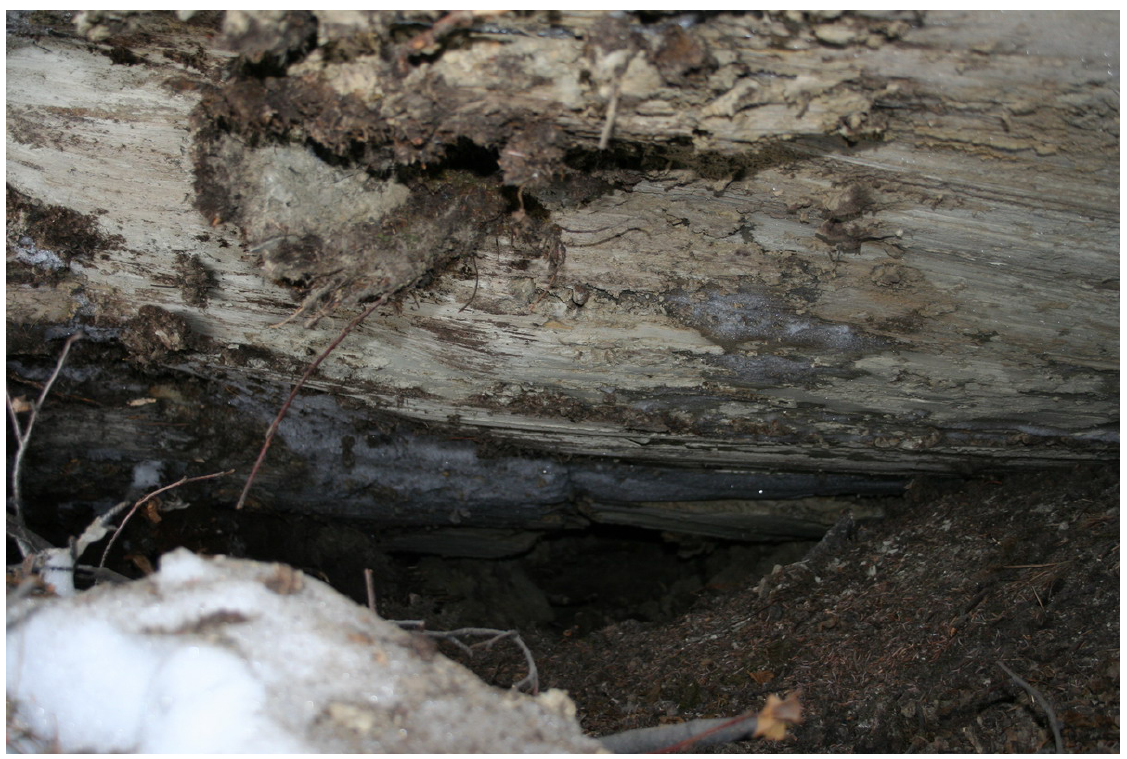
Figure 11. Striations on the underside of a block of frozen silty debris indicate sliding motion in the frontal lobe of FDL-A during and after soil freezing. Below is the original ground surface, littered with recent organic matter, and above is the seasonally frozen ground that slid over the original ground. Ice can be seen in cracks as well as streaks on the underside from the sliding motion.